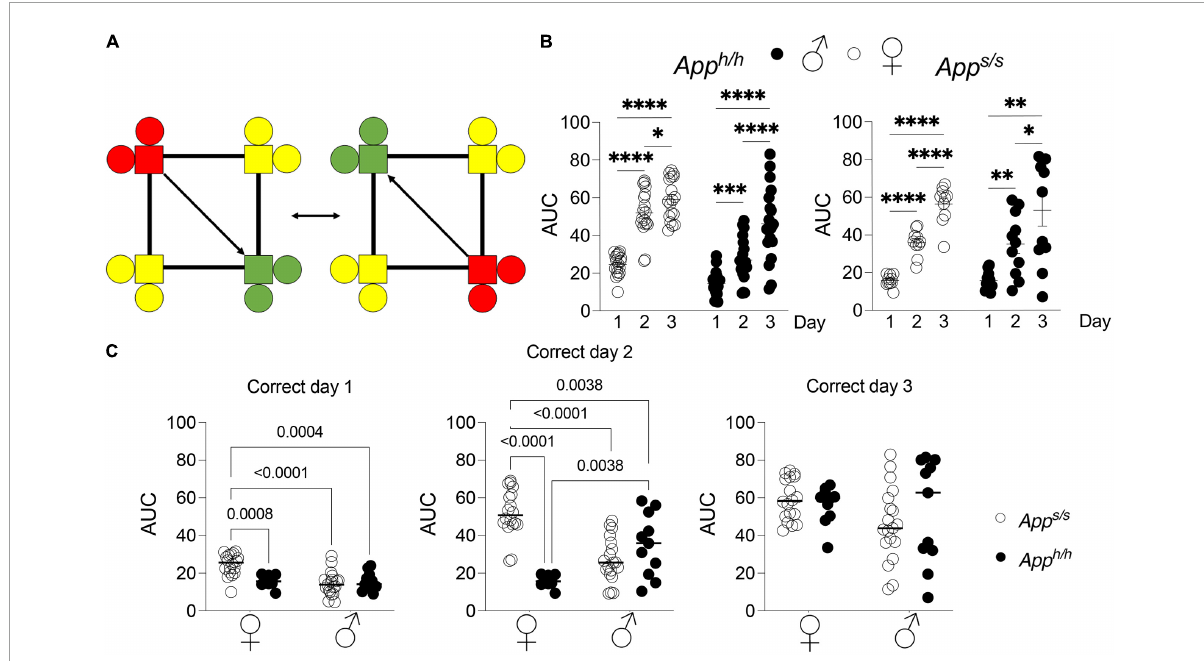
FIGURE3 Behavioral sequencing analysis of App h / h and App s / s rats. (A) Schematic of behavioral sequencing program on top left, for a rat assigned to corner 2 or 4. Green indicates “correct” corner which then alternates to an adjacent corner after a nosepoke, with yellow indicating “incorrect” corners and red indicating “opposite i.e., incorrect, previously correct” corner. (B) Area under the “correct learning curve analyses for individual rats stratified by each day of the drinking session. Data are represented as mean ± SEM and were analyzed by two–way RM ANOVA followed by post-hoc Sidak’s multiple comparisons test when ANOVA showed significant differences ( App h / h rats: day factor, F ( 1 . 870 , 65 . 45 ) = 118.6, P < 0.0001; sex factor, F ( 1 , 35 ) = 27.08, P < 0.0001; day × sex interaction, F ( 2 , 70 ) = 6.697, P = 0.0022; post-hoc Sidak’s multiple comparisons test, females day 1 vs. day 2 P < 0.0001; day 1 vs. day3 P < 0.0001; day 2 vs. day 3 P = 0.0359, males day 1 vs. day 2 P = 0.0006; day 1 vs. day3 P < 0.0001; day 2 vs. day 3 P < 0.0001. App s / s rats: day factor, F ( 1 . 525 , 28 . 98 ) = 65.85, P < 0.0001; sex factor, F ( 1 , 19 ) = 0.09169, P = 7653; day ×